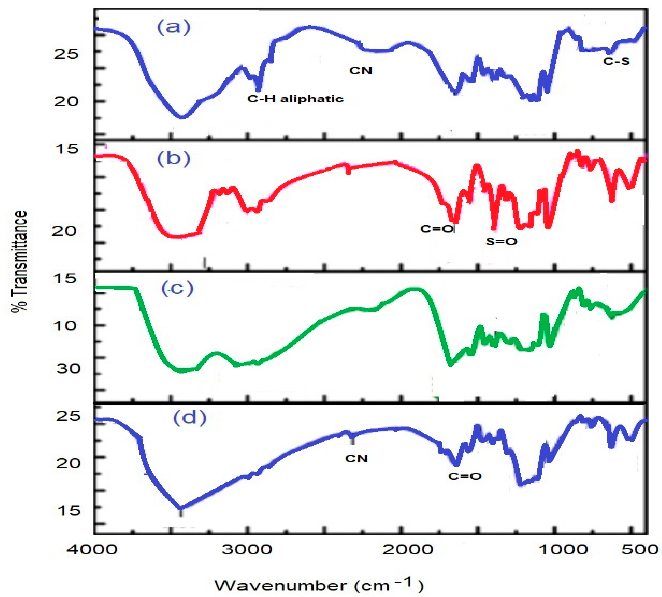
Figure 2. FTIR spectra of ( a ) M4, ( b ) M2, ( c ) M3 and ( d ) M0 polymers.